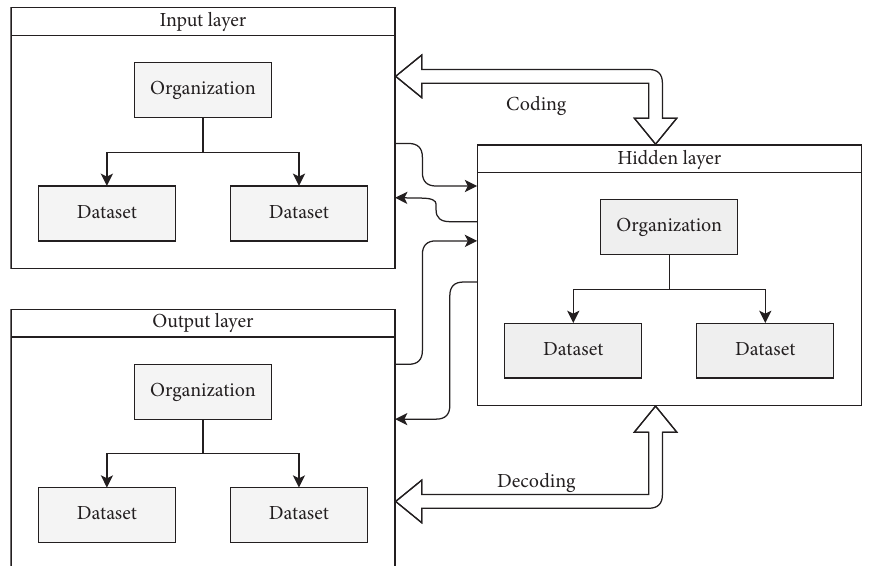
Figure 6: Block diagram of the deep network of autoencoding and decoding.